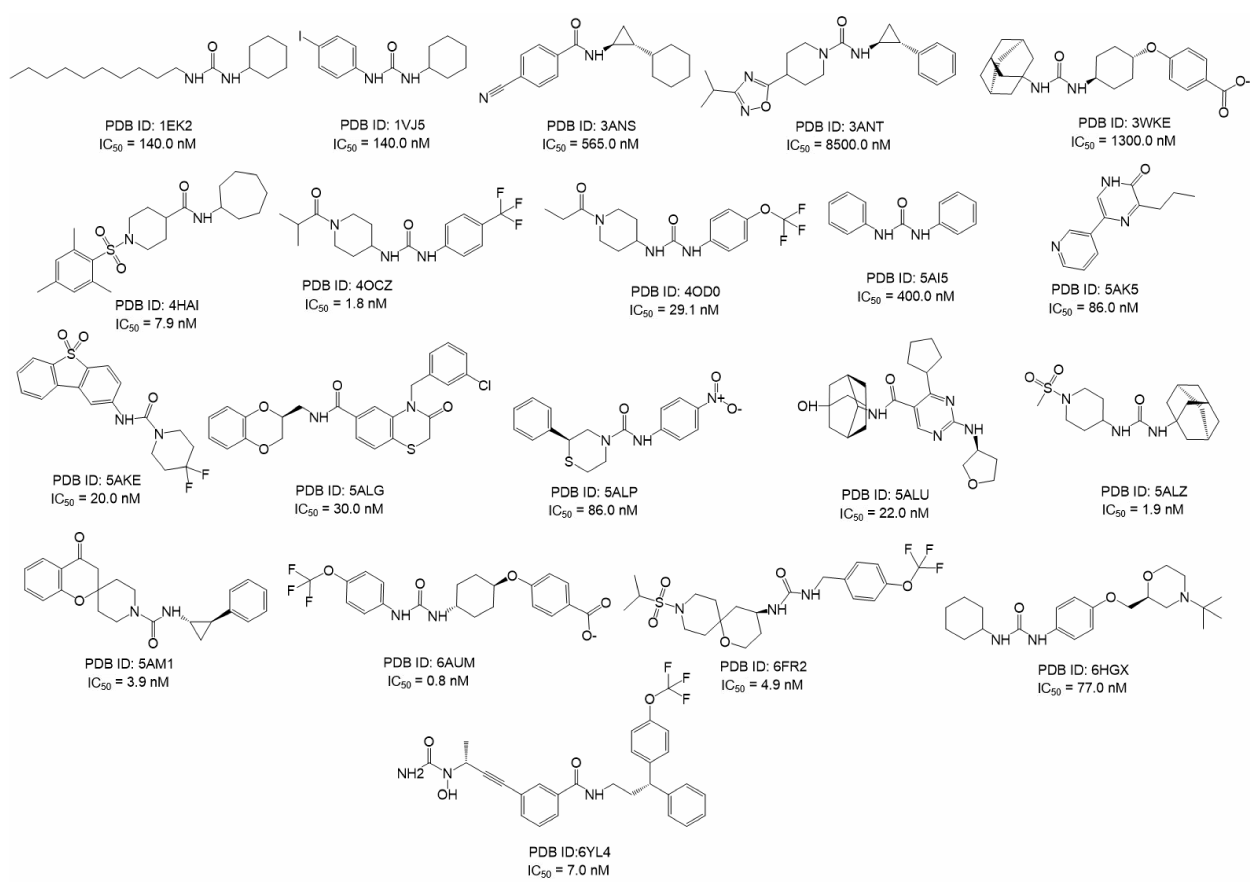
Figure 5. 2D structures of known sEH inhibitors co-crystallized selected for the development of the 3D structure-based pharmacophore models, featuring their relative PDB code and IC 50 values